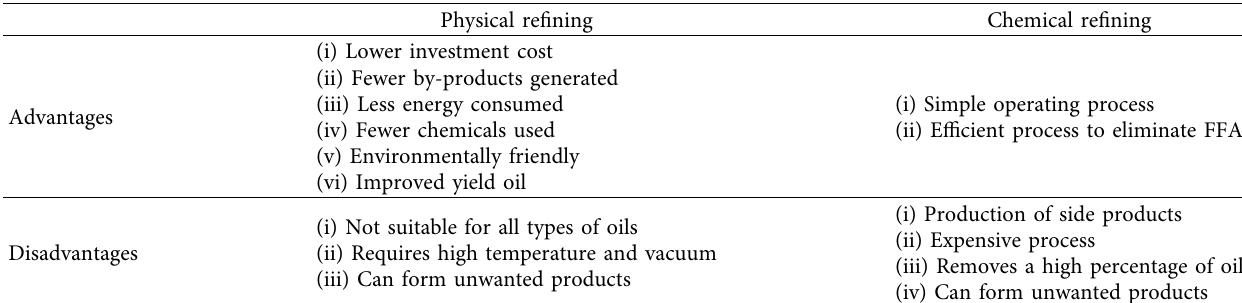
Figure 2: General overview of the chemical and physical refining process of crude oil. Table 2: Advantages and disadvantage of chemical and physical